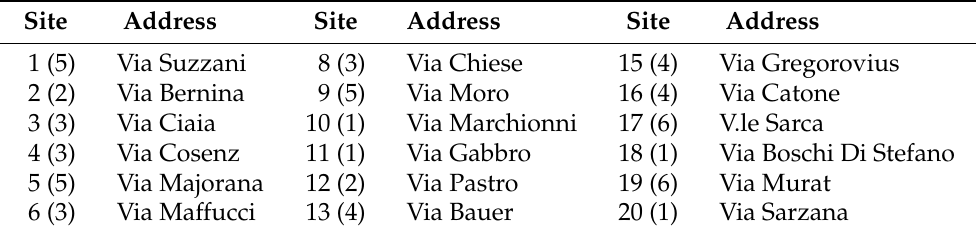
Table 4. Location of the measurement sites (cf. Figure 6). The group index g i is indicated in parentheses [91].